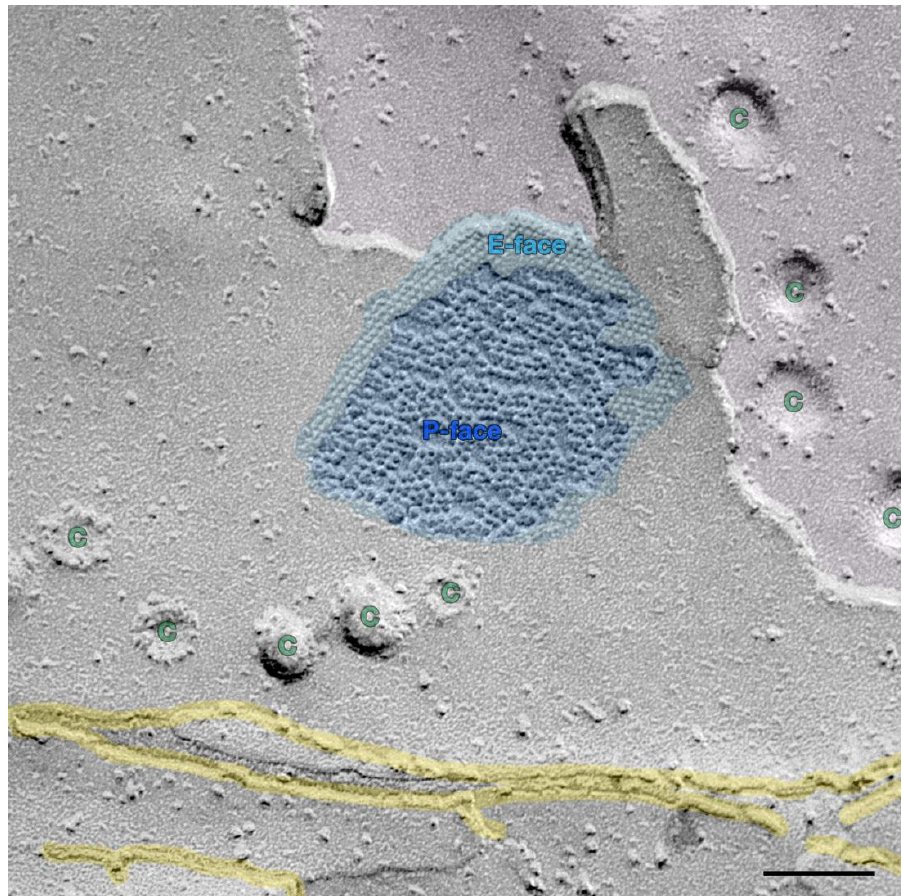
Figure 1. Freeze-fracture image of a gap junction in the myelin sheath of an optical nerve axon (mouse), consisting of P-face (the P-face, close to protoplasm, is the inner lamella of the plasma membrane viewed from outside the cell; deep blue) particles and E-face (the E-face, close to the extracellular space, is the outer lamella of the plasma membrane viewed as if from within the cell; pale blue) pits, surrounded by tight junctions (yellow) and caveolae (green ‘C’s). Underlying myelin layer in pale red. Scale bar depicts 0.1 µm.